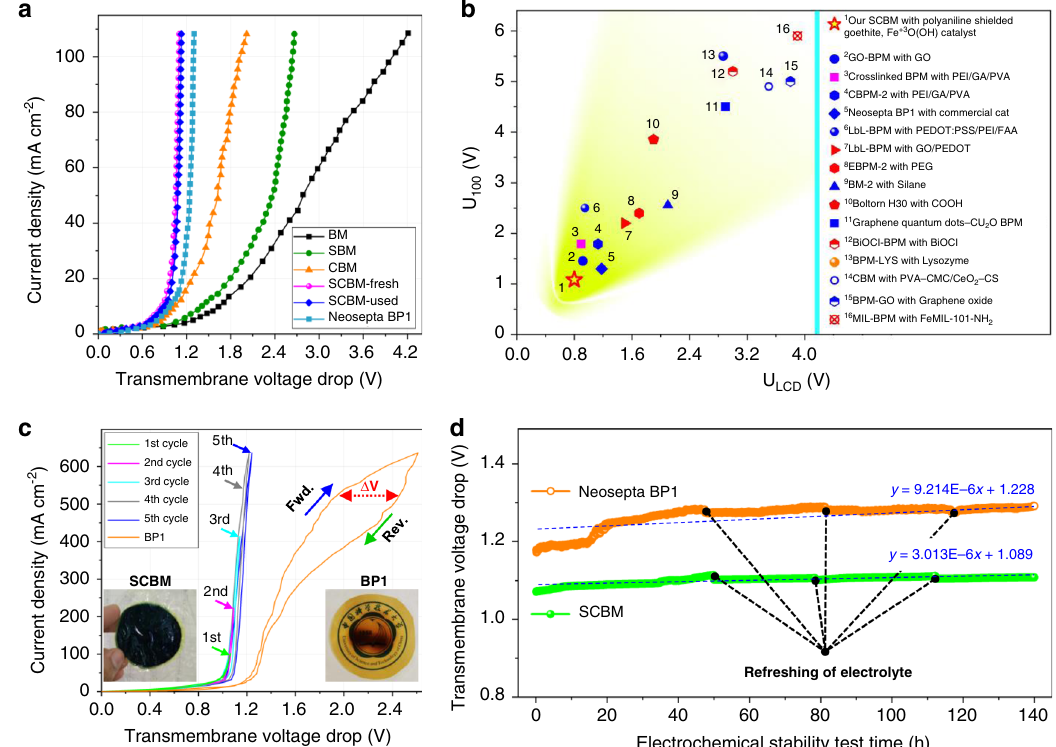
Fig. 5 Galvanostatic polarisation analysis con fi rm fast and stable water dissociation. a The I – V curves up to 109 mA cm − 2 current density for the bipolar membranes without catalyst (BM), containing only the PANI shields (SBM), containing only the ex-situ synthesised and spray-deposited catalyst (CBM), fresh SCBM, thoroughly used SCBM, and a fresh commercial Neosepta BP1. The polarisation curves indicating the requirement of a very small WD voltage at the LCD and 100 mA cm − 2 current densities with the SCBMs ( U LCD : 0.8 V and U 100 : 1.1 V) than the BP1 ( U LCD : 1.1 V and U 100 : 1.3 V). b Comparative electrochemical characteristics showing very low U LCD and U 100 voltages for the SCBMs (presented as a star at the lower right corner) than the previously reported CBMs. c The electrochemical stability test of the SCBMs and BP1 membranes during fast water dissociation. Initial four I – V cycles (1st – 4th) were recorded for a fresh SCBM at loading – unloading – reloading current densities between 0 to 102, 223, 414, and 637 mA cm − 2 (within the testing limit), whereas the 5th cycle is for the same SCBM sample after a thorough use in EIS, I – V and SCBM-ED tests. A highly reversible trend in the I – V cycles is indicative of excellent electrochemical stability and membrane durability during ultrafast water dissociation at high operating current densities (right Inset, an undamaged SCBM). In contrast, a fresh BP1 scorched (left Inset, a symptom of the junction dehydration) during the stability test and could not behave reversibly after 300 mA cm − 2 (large passive potential difference, Δ V ). d Long-time electro-stability (almost 6 days, 140 h) of the membranes during water dissociation at 100 mA cm − 2 (within the testing limitation of AUTOLAB electrochemical workstation, PGSTAT 302N, Metrohm, Netherland). Linear fi tting with blue lines ( y = m x + c where m and c are slope and y-intercept, respectively) on the stability data indicates smaller transmembrane potential drop ( c = 1.089 V) and minor decline in water dissociation rate of SCBMs ( m = 3.013 µ V min − 1 ) compared with BP1 ( c = 1.228 V, and m = 9.214 µ V min − 1 ). The black dotted regions indicating sudden potential drops in the experimental data due to the refreshing of the electrolytes in the testing